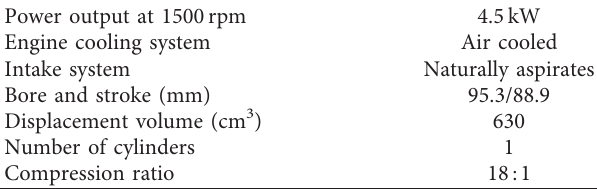
Table 1: Specifications of the diesel